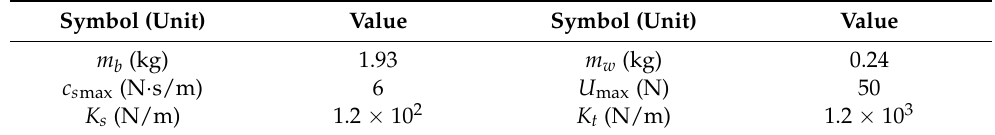
Table 6. The value of the test bench